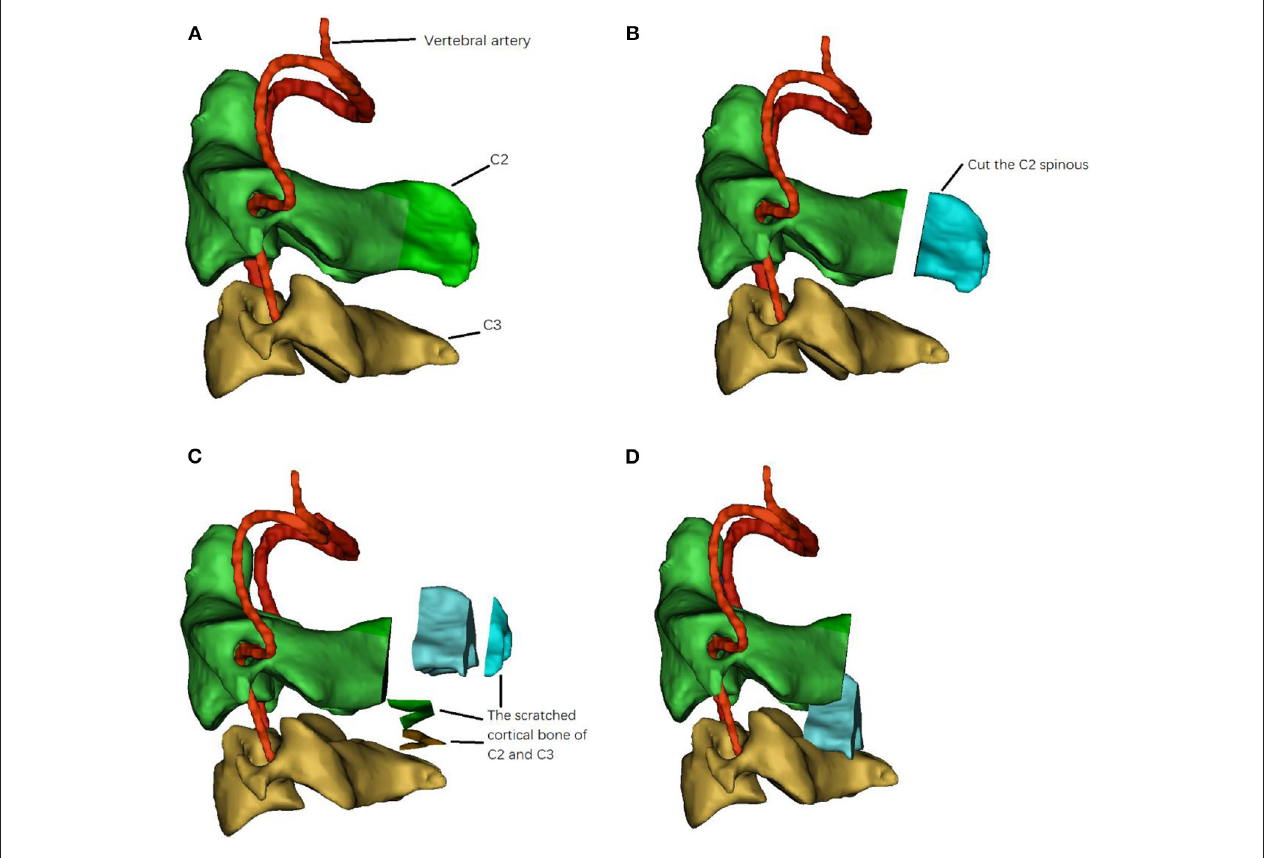
FIGURE 1 | The diagram of C2 spinous muscle complex graft. (A) the anatomy of C2, C3 and vertebral artery, (B) Cut down the posterior 3/4 of C2 spinous, (C) scratch the cortical of C2 and C3 for bone graft, (D) displace the C2 spinous muscle complex graft into C2-3 posterior arch.